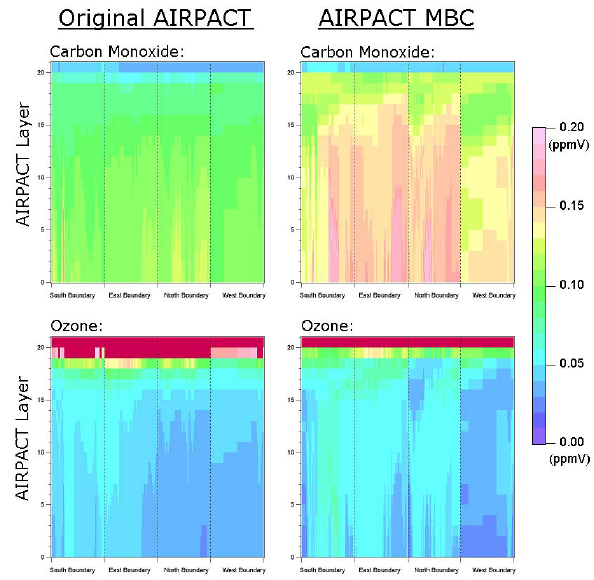
Fig. 2. Typical nighttime carbon monoxide and ozone boundary conditions for the original AIRPACT-3 BCON (left) and the up- dated dynamic boundary conditions (right). 16 May 2010 is